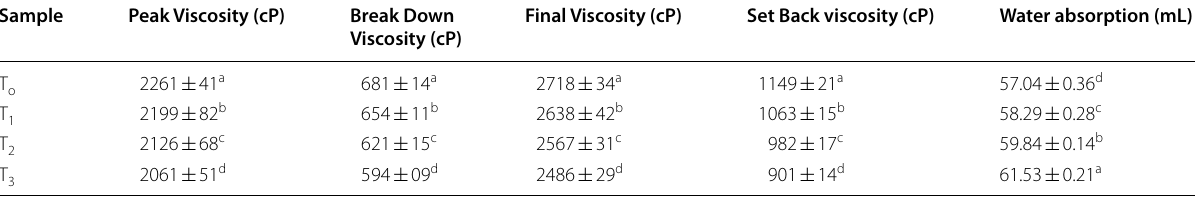
Values are means of triplicates HSD-Tukey Test T 0 0% BPP 100% WF; T 1 = +